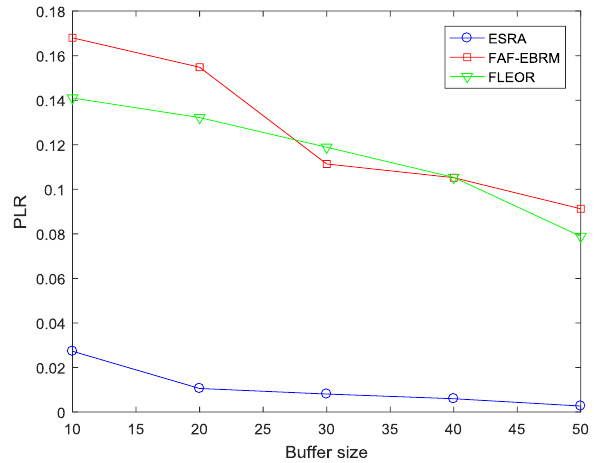
Figure 6. The PLR comparisons with varying buffer size.